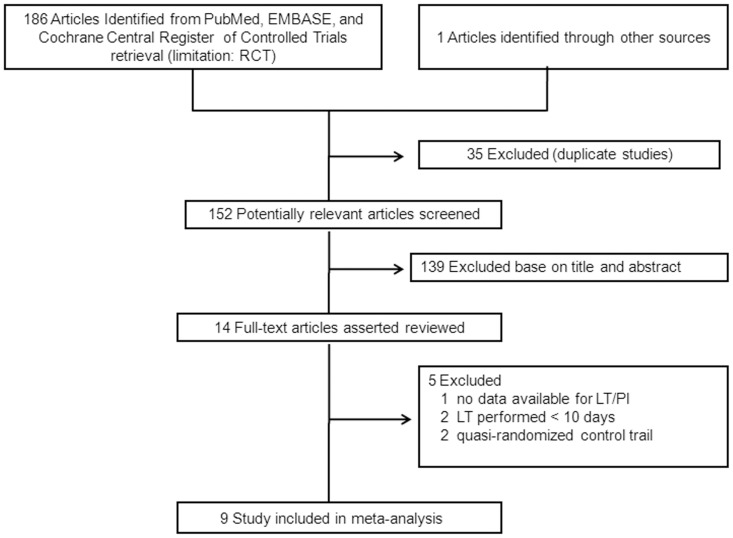
Selection process for randomized controlled trials included in the meta-analysis.